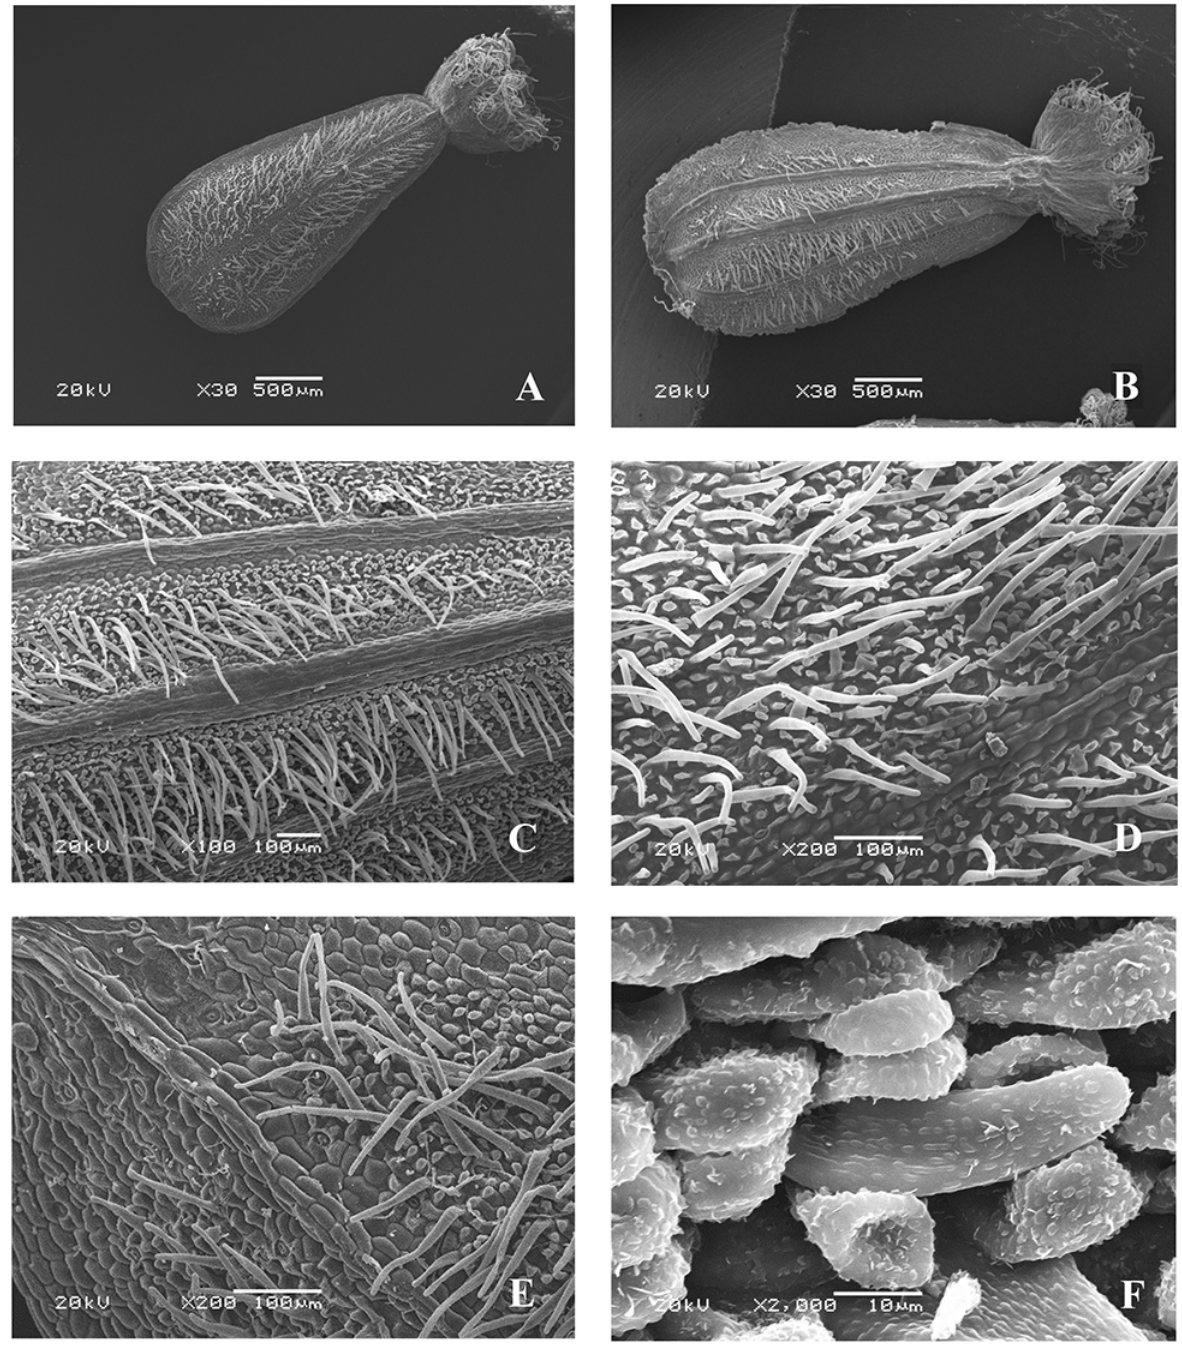
Figure 9 Fruits of Valeriana stolonifera Czern. (SEM): General view, adaxial side ( A ); general view, abaxial side ( B ); fragments of the fruit surface ( C–F